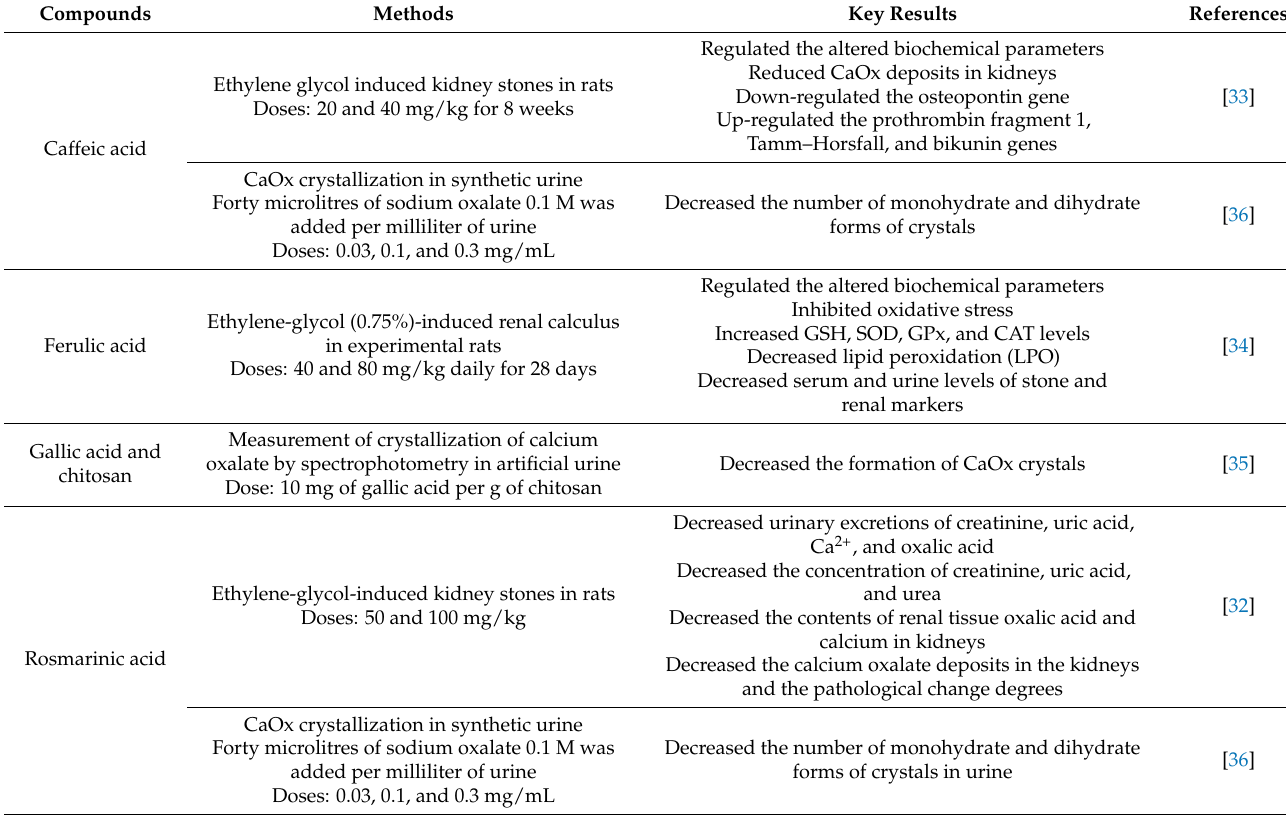
Table 3. Anti-urolithiasis effects of phenolic